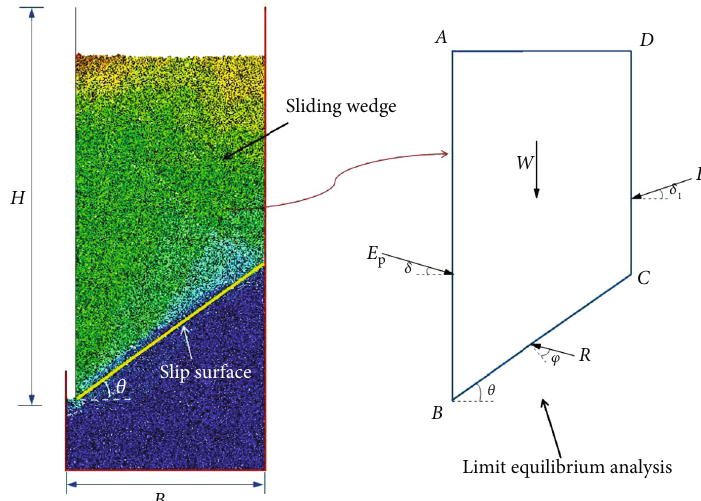
Figure 10: Schematics of calculation model.